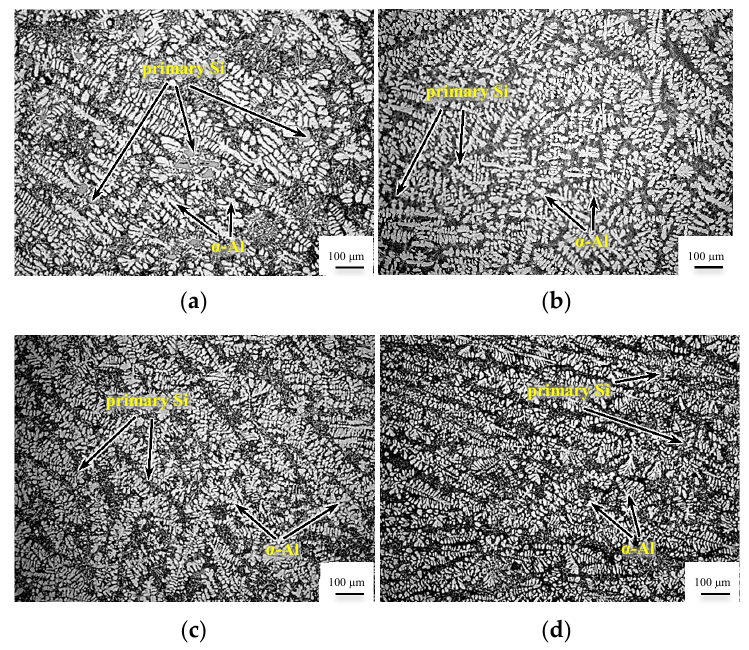
Figure 14. Microstructures on the edge of the billet: ( a ) conventional process; ( b ) 100 A; ( c ) 150 A; ( d ) 200 A.